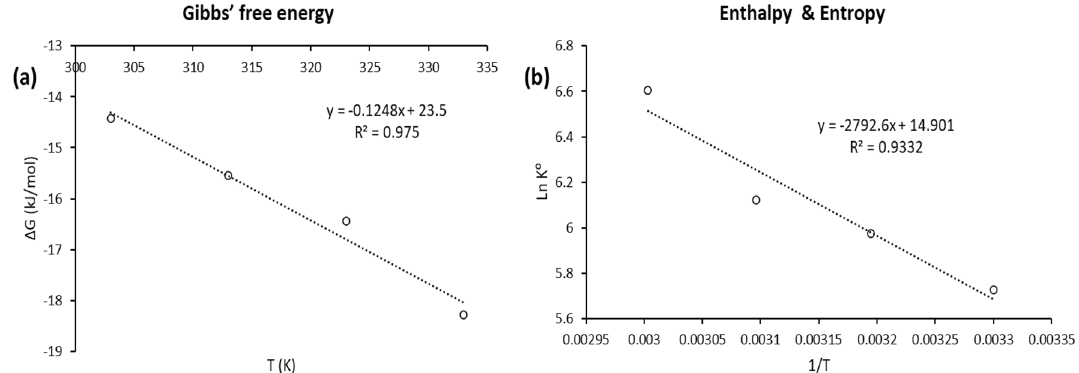
Fig. 8 a Plot of Gibbs’ free energy change vs temperature, b Plot of ln Kº vs 1/ T to determine the enthalpy (Δ H °) and entropy (Δ S °) Table 2 The thermodynamic T (ºK) K º (mL/g) Ln K º Δ G º (kJ/mol) Δ H º (kJ/mol) Δ S º (J parameters and the distribution and adsorption constants for the adsorption of MB onto nZVAl nanoparticles ([MB] = 30 mg/L; nZVAI dosage = 1 g/L) at different temperatures